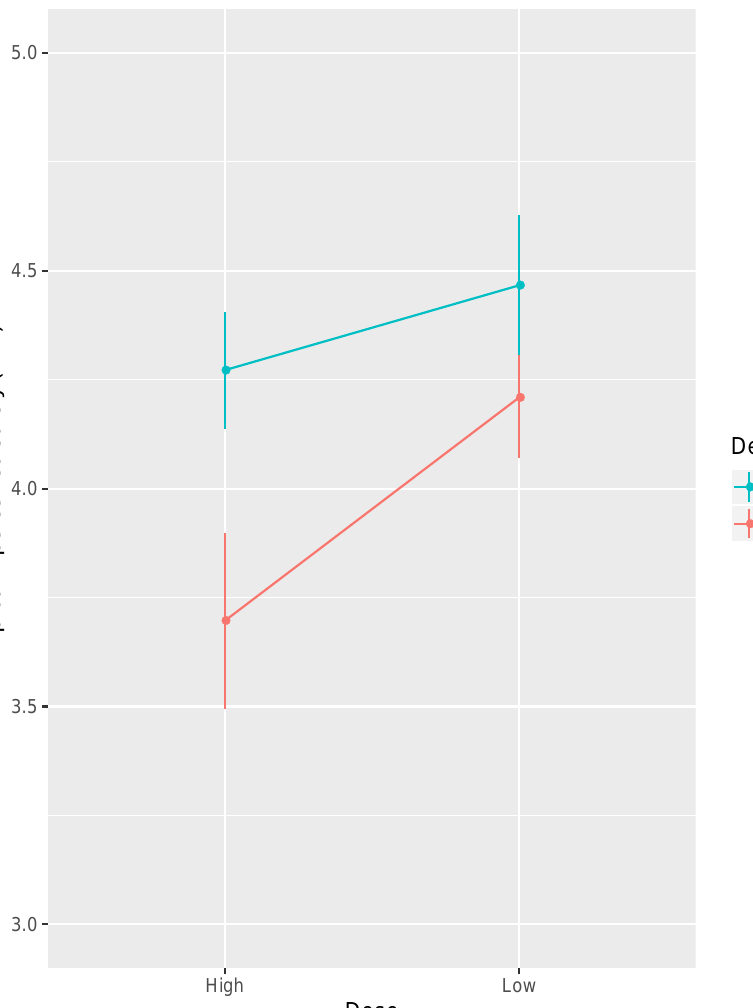
Table 1. ANOVA results.